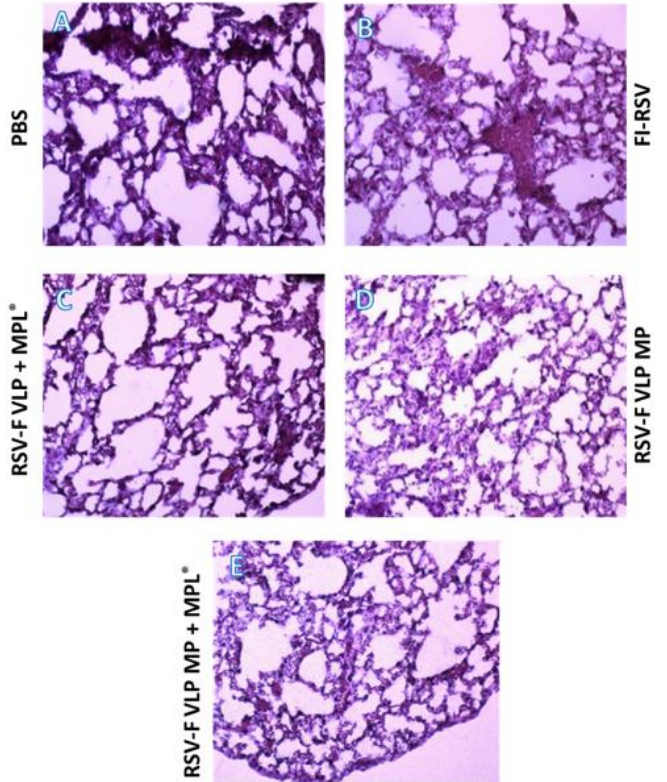
Figure 6. Lung tissues were collected from individual mice ( n = 5 per group). Lung tissue sections were stained with hematoxylin and eosin (H&E) to assess inflammation. ( A ) PBS (control); ( B ) FI- RSV (I.M.); ( C ) RSV-F VLP + MPL ® (T.D.) suspension; ( D ) RSV-F VLP MP (T.D.); ( E ) RSV-F VLP MP + MPL ® (T.D.).